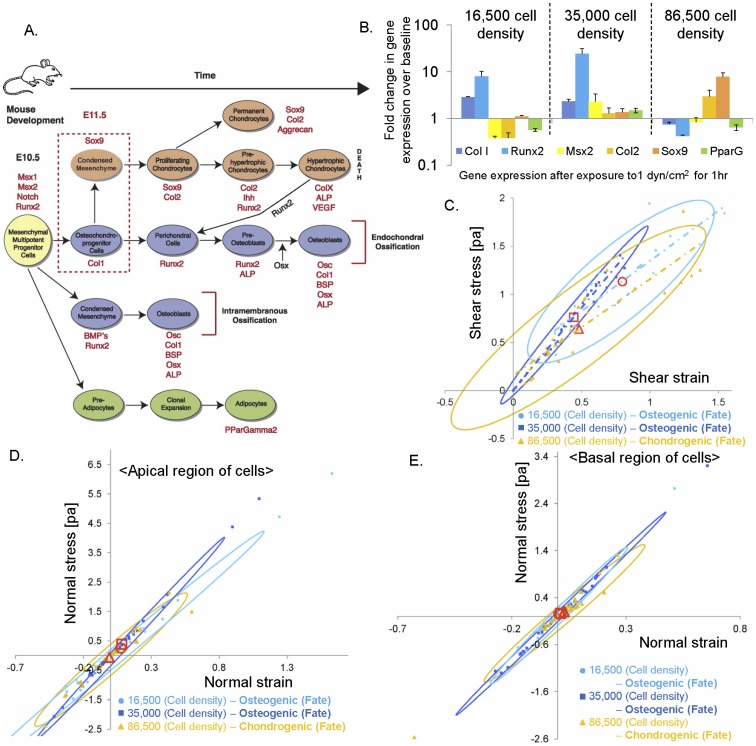
Stress - strain - fate plots to probe the live stem cell's mechanome, in a case study in live stem cells exposed to 1 dyn/cm2 shear stress via fluid flow.(A) After mesenchymal condensation (red dotted box, E11.5 in the mouse), the first step in skeletogenesis, stem cells follow lineage commitment paths toward chondrogenic (orange), osteogenic (blue), and adipogenic (green) fates. Transcription levels for specific proteins (red text) give a “chronological fingerprint” for each stage of development over time [1]. (B) For live stem cells exposed to 1 dyn/cm2 shear stress over 60 minutes, rtPCR data provide fold changes in gene expression of markers above or below baseline (no flow exposure) gene expression levels, based on analysis of previously reported data [31]. (C) Stress - strain - fate plot of live stem cells exposed to 1 dyn/cm2 shear stress over 60 minutes, where fate is indicated by color (osteogenic: blue, chondrogenic: orange). Linear regression of experimental data shows distinct slopes for each density and resultant fates, including osteogenic (blue: 1.04 [Pa], R2∼0.7, 16,500 cell density [cells/cm2]; navy: 0.9997 [Pa], R2∼0.78, 35,000 cell density [cells/cm2]), and chondrogenic lineage commitment (orange, 1.7124 [Pa], R2>0.8, 86,500 cell density [cells/cm2]). Red overlay shapes indicate mean strain stress at each density. Ellipses show 95% density area for each density. D. Local (apical), normal stress-strain (XY plane) relationship, depicting lineage commitment, including osteogenic (blue: 3.8513 [Pa] at 16,500 cell density [cells/cm2]; navy: 4.8513 [Pa] at 35,000 cell density [cells/cm2]) and chondrogenic lineages (orange: 3.8525 [Pa] at 86,500 cell density [cells/cm2]); all R2>0.8. Red shapes indicate mean stress and strain at each density. Ellipses indicate 95% density area for each density. E. Local (basal), normal stress-strain (XY plane) relationship, depicting lineage commitment, including osteogenic (blue: 4.9413 [Pa] at 16,500 cell density [cells/cm2]; navy: 4.8059 [Pa] at 35,000 cell density [cells/cm2]) and chondrogenic lineages (orange: 4.0653 [Pa] at 86,500 cell density [cells/cm2]); all R2>0.8. Each data point is shown from cohorts of cells in the field of view.